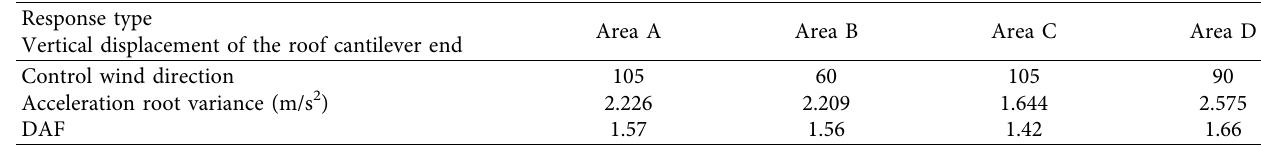
Table 2: Dynamic amplification factor and the control wind direction angle.